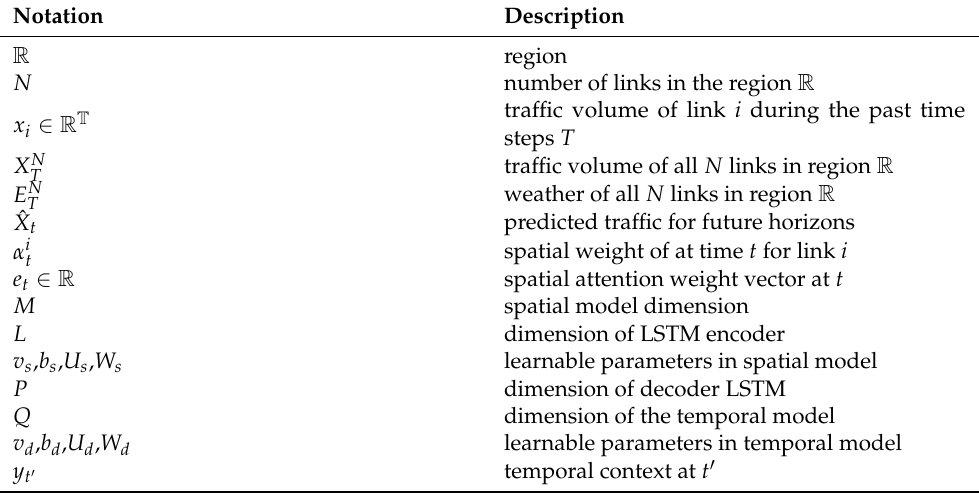
Table 1 lists the notations used in this paper. Table 1.